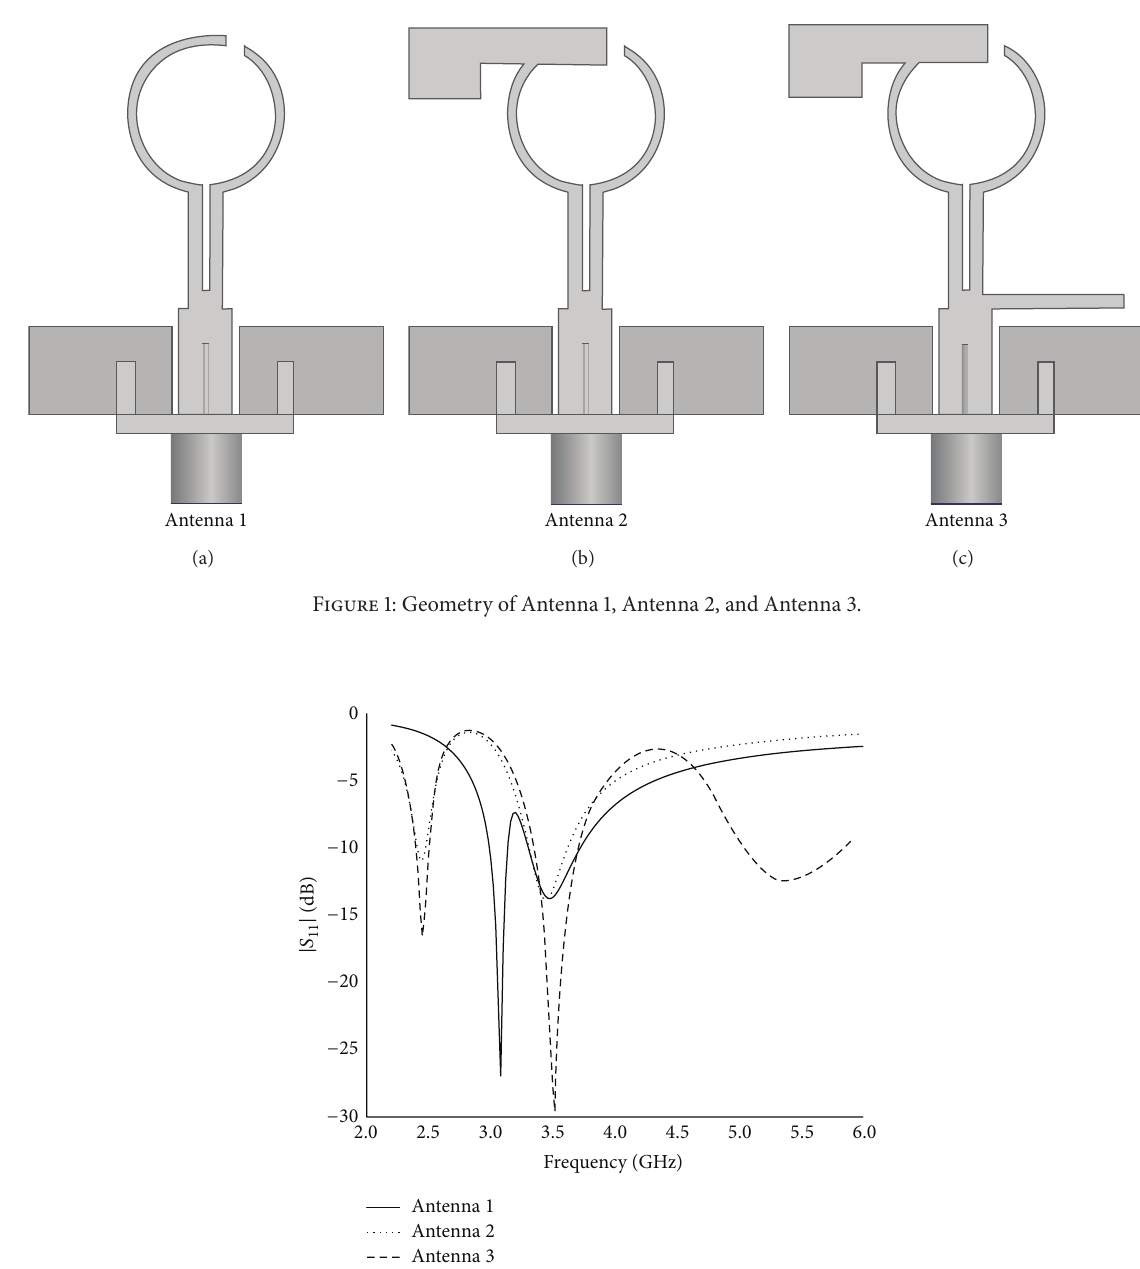
Figure 2: Simulated |𝑆 11 | of Antenna 1, Antenna 2, and Antenna